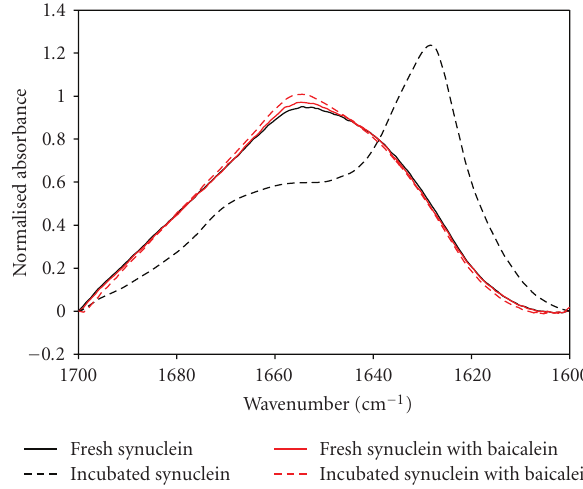
Figure 9: Secondary structure analyses of α -synuclein in the presence of baicalein by ATR-FTIR (red lines). The spectra of α -synuclein alone before and after incubation was presented for comparison (black